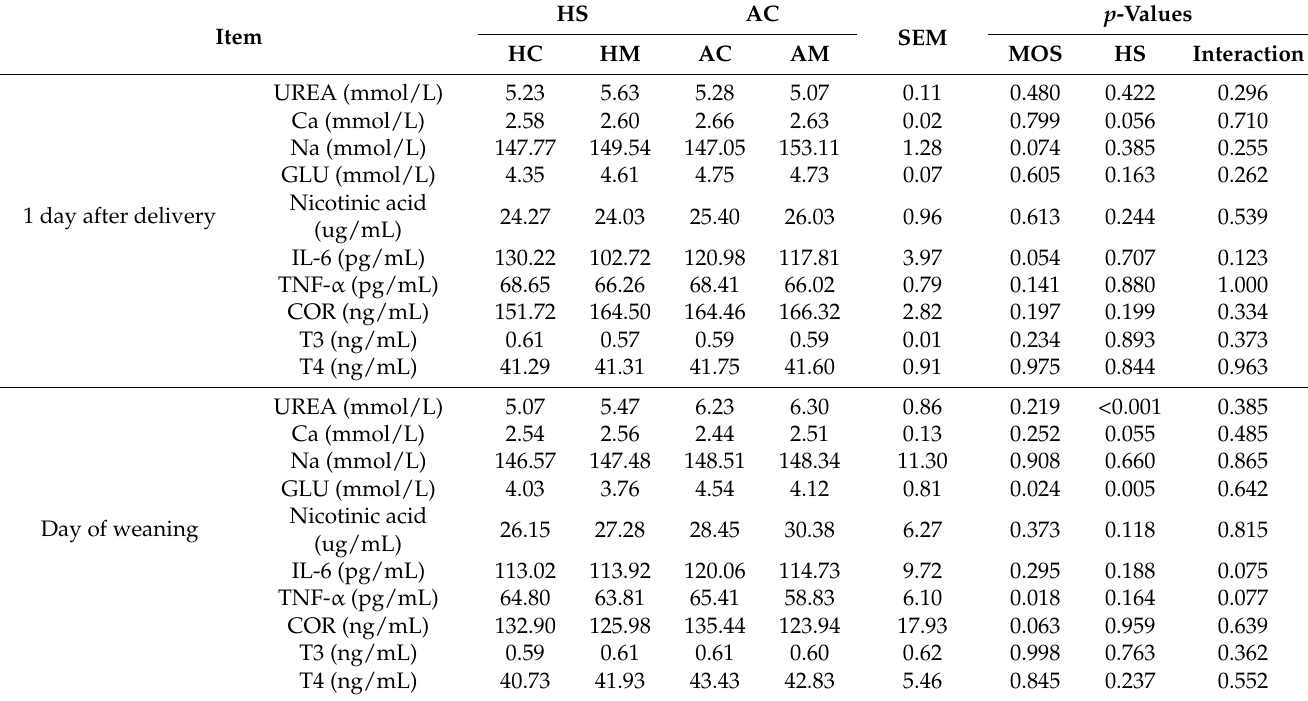
Table 5. Effects of dietary supplementation with MOS on the serum index of sows subjected to HS or AC